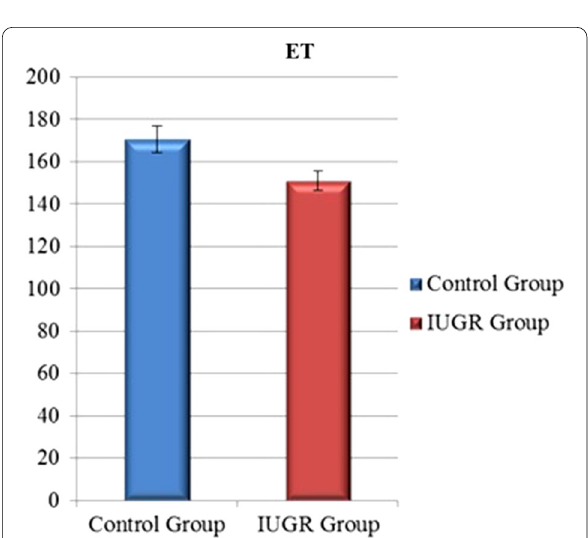
Fig. 2 Comparison between control and IUGR groups according to ET